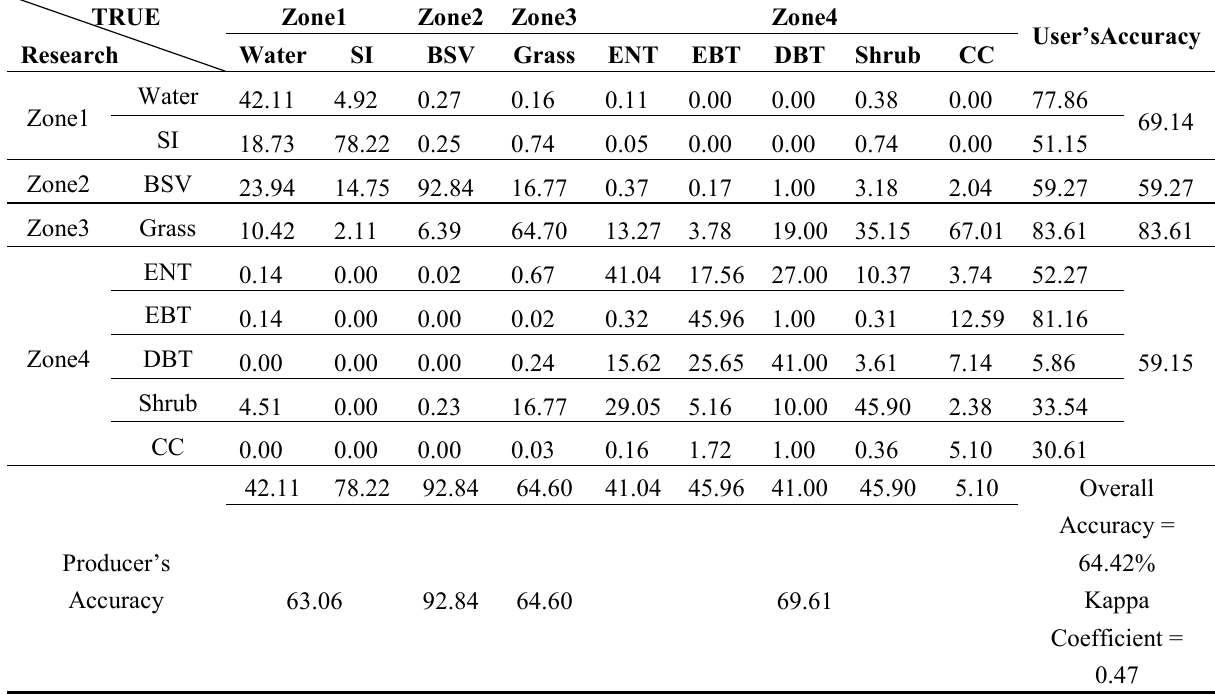
Table 1. Confusion matrix of the hierarchical soft classification map: aggregated (the four broad categories) and detailed (plant functional types) accuracies are shown below (based on 13,081 reference points selected from Chinese Vegetation Map). For simplicity, vegetation types represented by initials in bracket: evergreen needle leaf trees